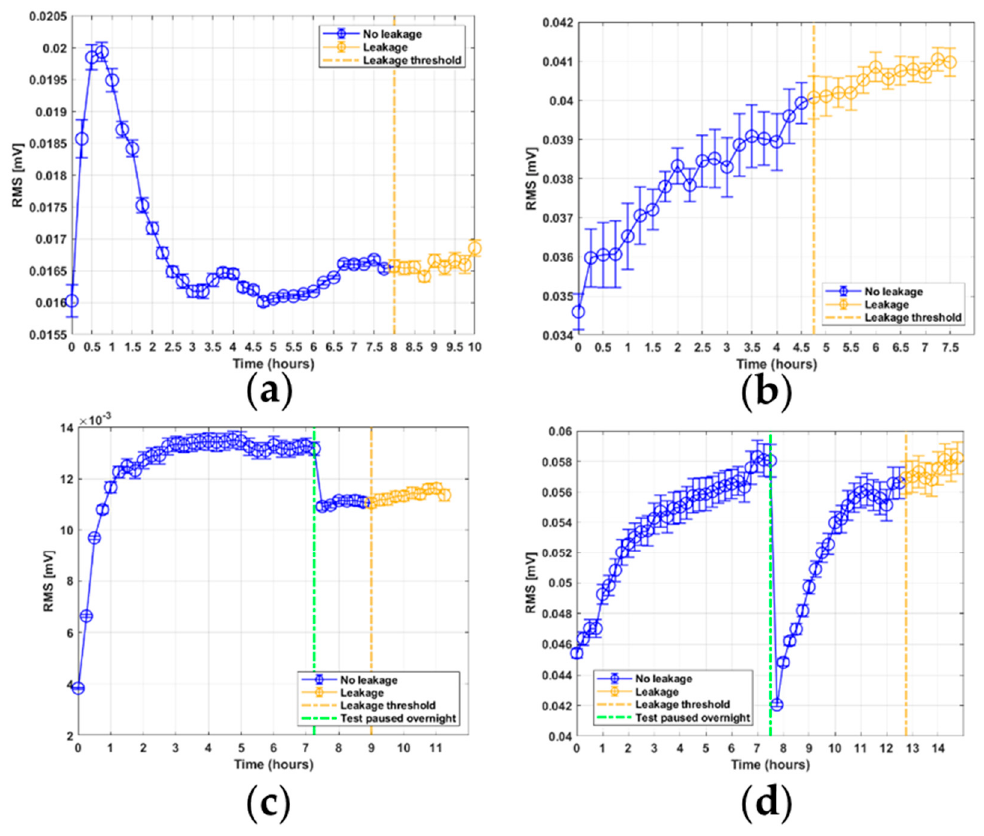
Figure 13. RMS feature from RTF tests, bandpass filtered between 60 and 80 kHz: ( a ) test 1; ( b ) test 2; ( c ) test 3; ( d ) test 4.